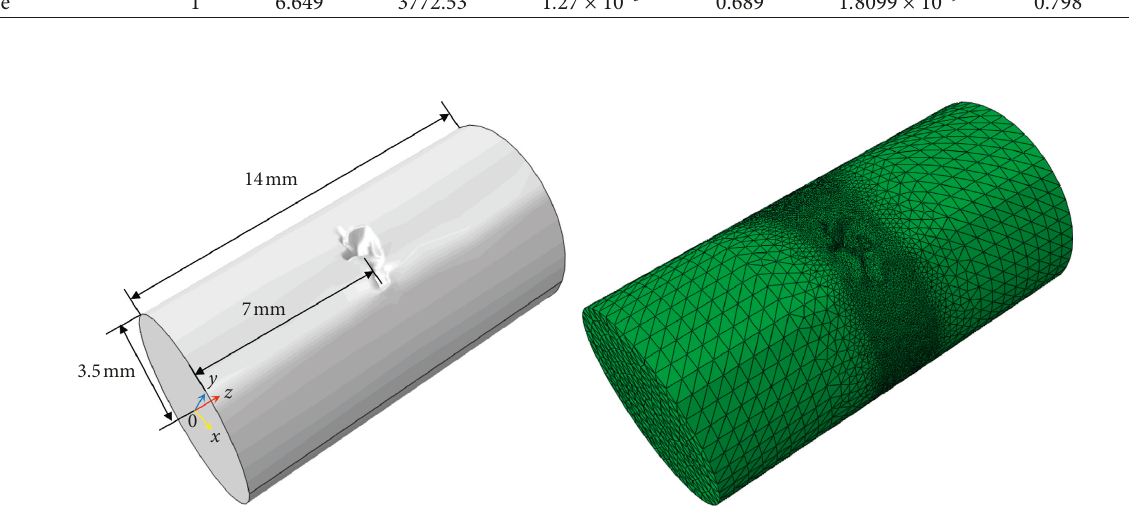
Figure 13: The FE model of high-strength steel wire with an initial corrosion